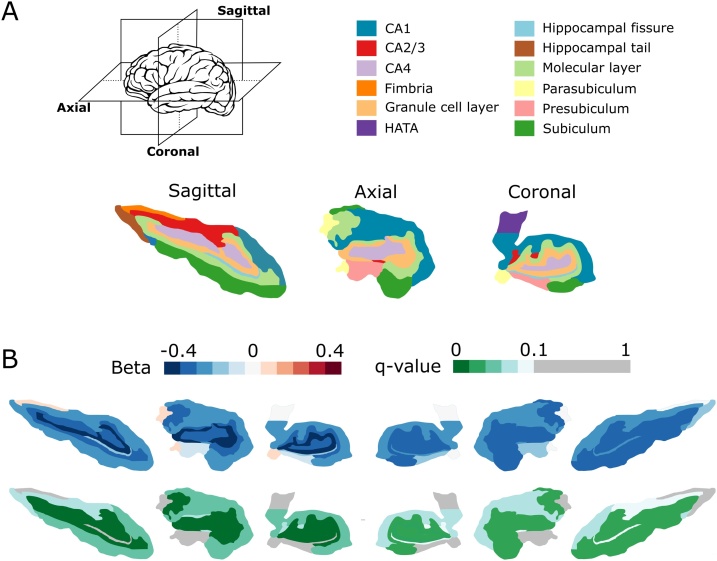
Visual representation of the predictive ability of the best-fit PRS for estradiol on hippocampal subfield volume. A. Example sagittal, axial and coronal cross-sections of the human hippocampus segmented from an example MRI image using FreeSurfer and colour-coded to indicate each hippocampal subfield. B. For each hemisphere and subfield combination, the results of the linear regression are represented in a scale of dark blue (β=−0.4), through white (β=0), to dark red (β=0.4) for the beta coefficient, and green to white for the FDR-corrected q-value. Relationships which did not survive the FDR correction are represented in grey (q>0.1). The six figures to the left relate to the left hippocampus, and the six figures to the right relate to the right hippocampus. Relative hippocampal subfield structure is for visualisation only and is not representative of all participants. The numerical data is available in Table 3.